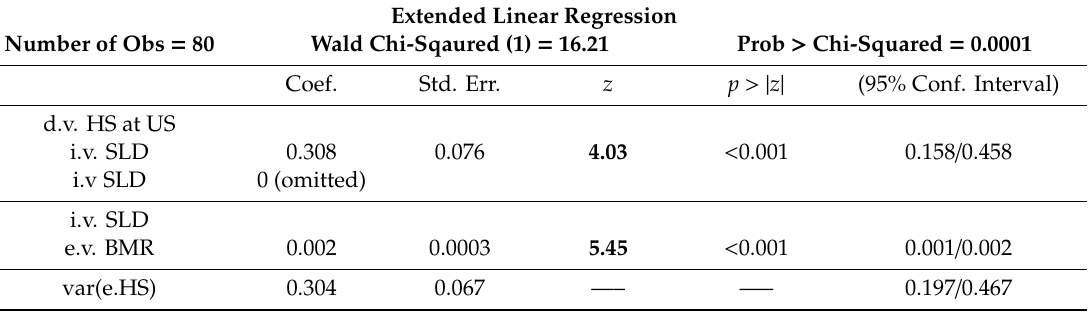
Legend to Table 9: HS at US, hepatic steatosis at ultrasonography; SLD, spleen longitudinal diameter; BMR, basal metabolic rate.